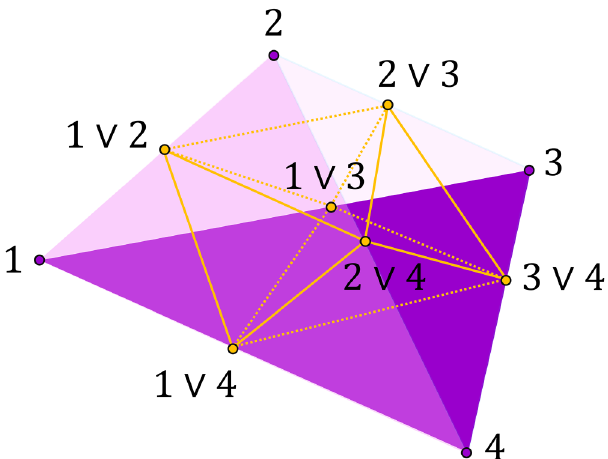
FIG. 3. Three-dimensional representation of the (ontic) state and effect spaces of the GPT underlying Spekkens’ toy theory. This is a simplex whose vertices correspond to vectors spanning R 4 . The (epistemic) state and effect spaces of the subGPT (i.e., Spekkens’ toy theory) is obtained by imposing the knowledge balance principle, which are given by octahedra inside the GPT’s state and effect spaces. Clearly, while the state and effect spaces of the GPT are dual to each other and satisfy the no-restriction hypothesis, the state and effect spaces of the subGPT are not duals and do not satisfy this hypothesis. Nevertheless, Spekkens’ toy theory is ontologically noncontextual according to Theorem 3, because it is a subtheory of an ontologically noncontextual